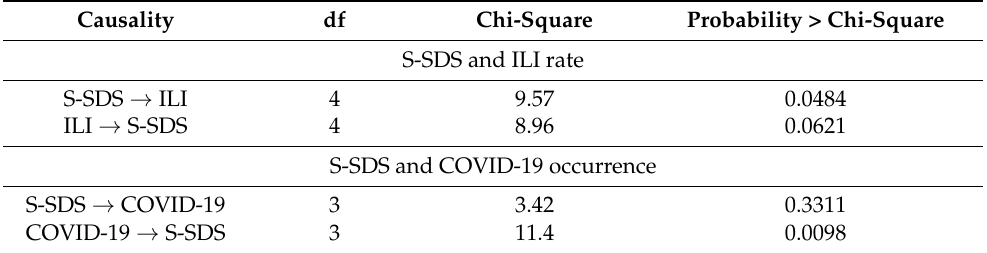
Table 2. Wald test for Granger causality between subway use-based social distancing score and influenza-like illness/coronavirus disease 2019. Causality df Chi-Square Probability > Chi-Square S-SDS and ILI rate S-SDS → ILI 4 9.57 0.0484 ILI → S-SDS 4 8.96 0.0621 S-SDS and COVID-19 occurrence S-SDS → COVID-19 3 3.42